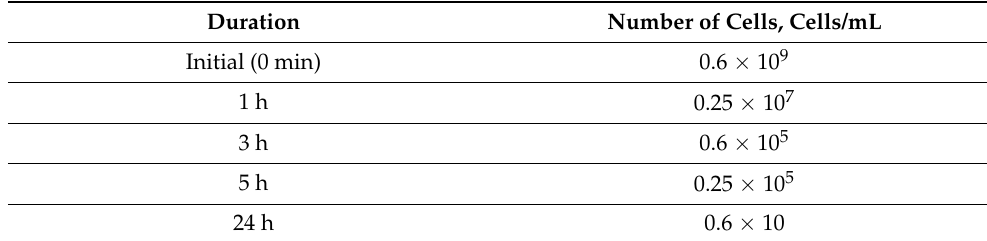
Table 2. Bacteria enumeration during bioleaching (PD 5%, initial pH-2.0, 20 g/L Fe 3+ , 40 °C, air -1 lpm, 600 rpm, duration-24 h).